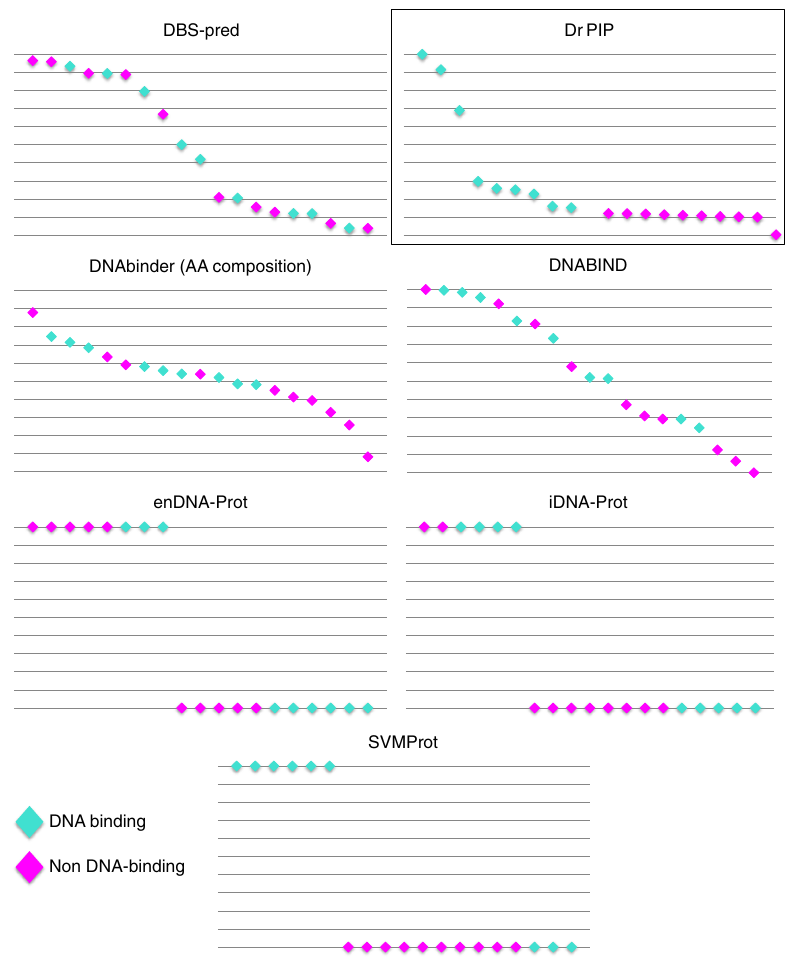
Figure 5 | Predictions of different methods for a set of proteins with no homology to known DNA binders. Cyan diamonds represent proteins annotated as DNA-binding that have no homology to any other known DBPs. Magenta diamonds represent proteins from the negative set of proteins that are unlikely to bind DNA. On the Y-axis is the score of the prediction method. Proteins are ordered by their score. Some methods provide binary predictions. Dr PIP fully separates positive and negative samples, with all binders with the higher scores and all the non-binders with lower scores.